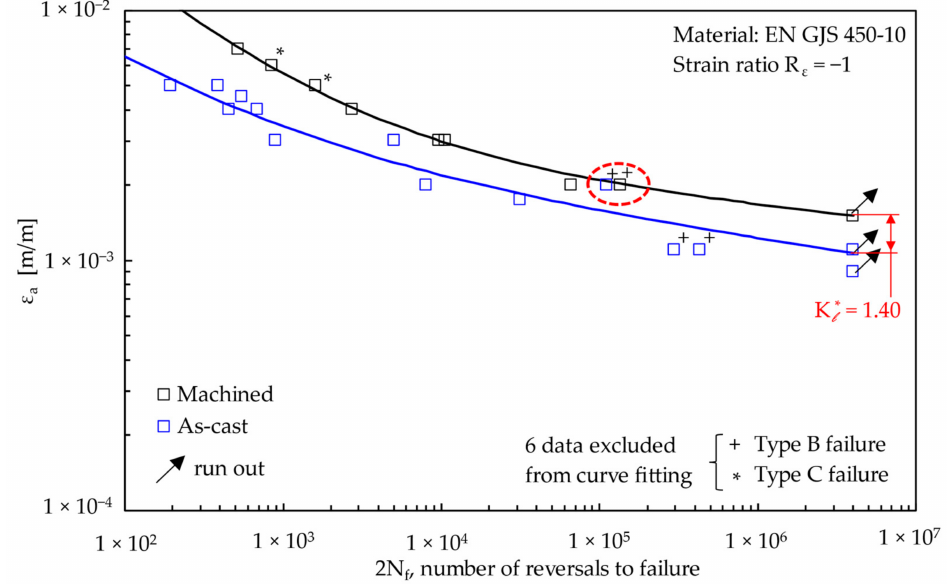
Figure 17. Comparison of the Manson–Coffin curves of EN-GJS-450-10 tested under R ε = − 1 in the machined (Figure 10a) and as-cast (Figure 10b) conditions. Derivation of the parameter K l*